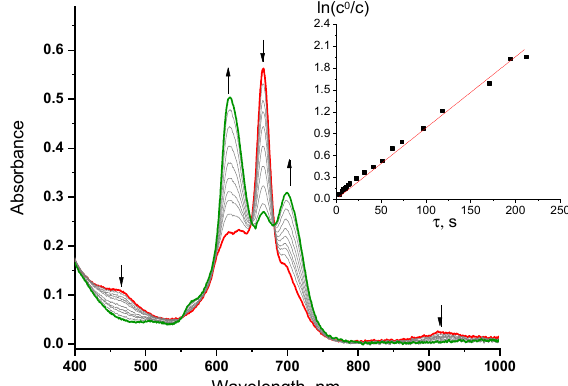
Figure 7. Changes in UV-vis for 4 in a THF solution (c = 1.2 × 10 − 5 mol/L) in the presence of phenylhydrazine (c = 3.3 × 10 − 4 mol/L) for 4 min (red curve–the initial spectrum, green–the final one). In-